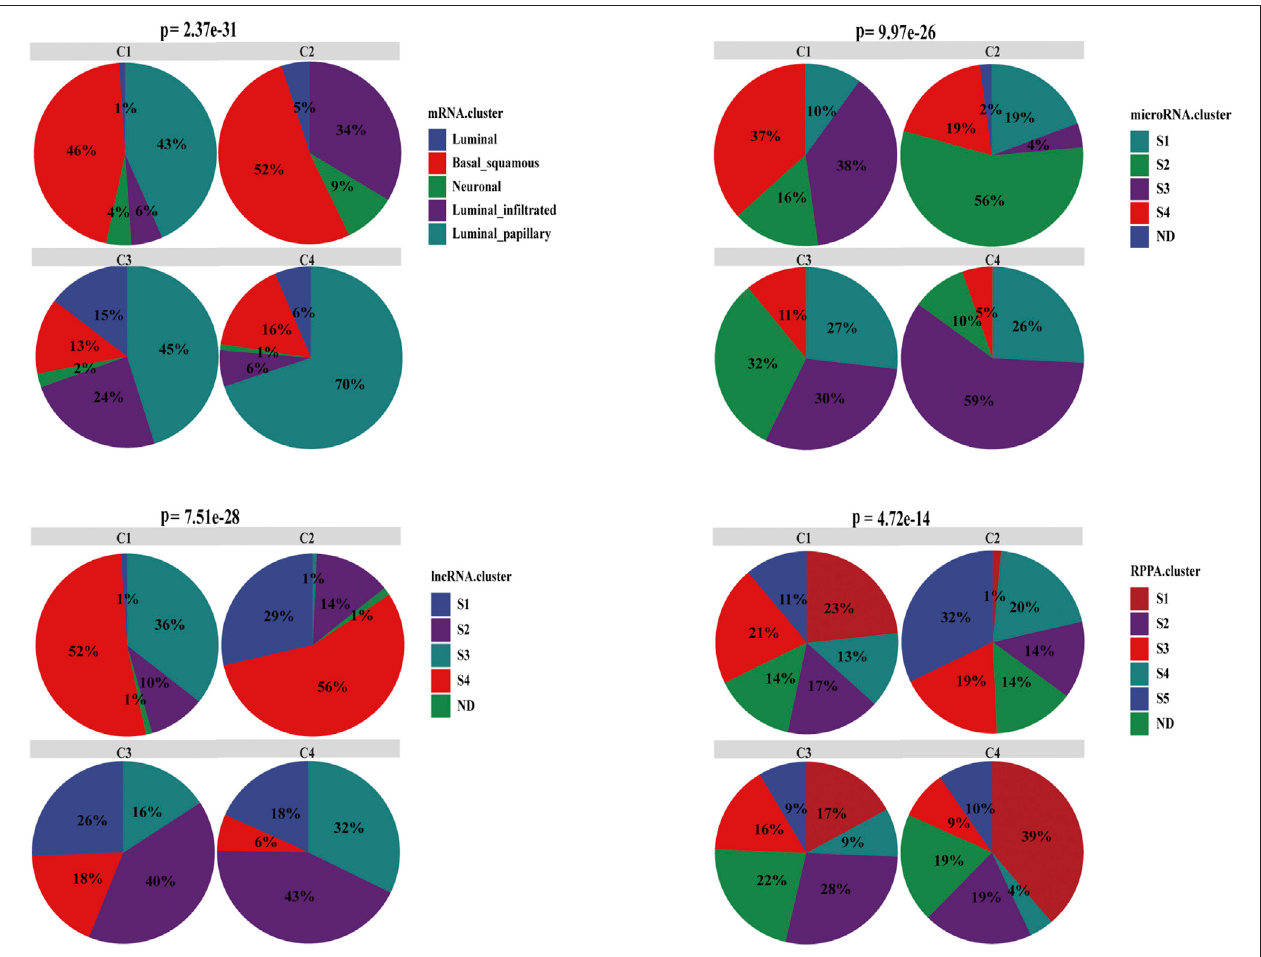
FIGURE 7 | Characterization of associations between the cell-state subtyping and other subtyping methods in BC. Compared with mRNA subtype, basal_squamous was enriched with C1 and C2, and luminal_papillary was enriched with C3 and C4. Compared with miRNA and lncRNA subtypes, C2 had the least miRNA S3 subtype and lncRNA S3 subtype, C1 was the second least, whereas S3 subtype had the best prognosis and low EMT. Conversely C1 and C2 had the most S4 subtype, and the S4 subtype correlated with relatively high EMT and always accompanied the worst prognosis. In comparison with RPPA subtype, C4 was dominated by S1 subtype, which indicated good prognosis and had the least C2, and conversely C4 had the least S4 subtype, which was correlated with the worst prognosis. ND meant that subtype was not determined or unknown.